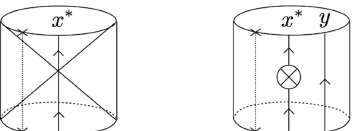
and V . The right diagram x x ∗ to V . x ⊗ y x ∗ ⊗ y